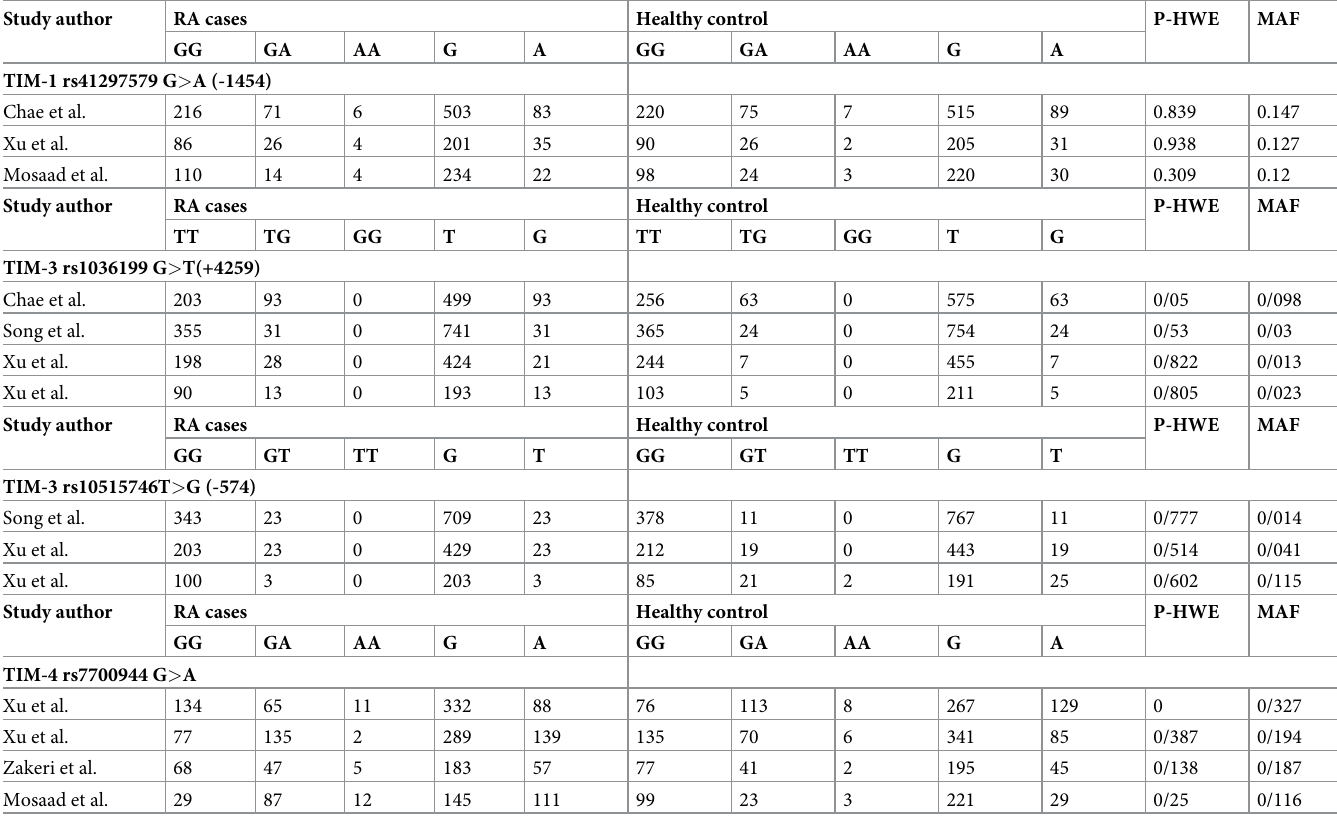
Table 2. Distribution of genotype and allele among RA patients and